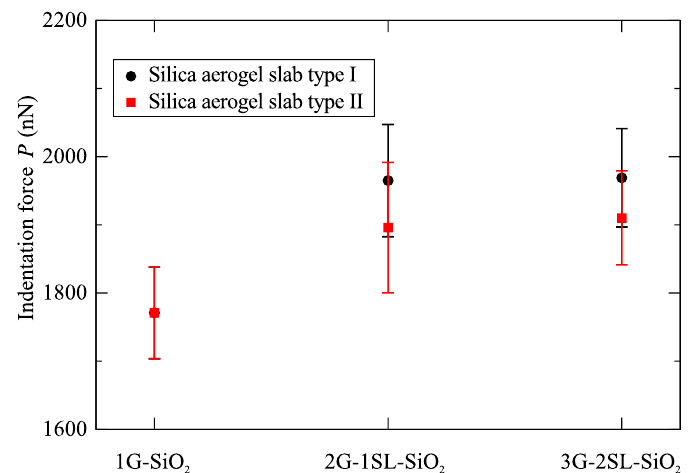
Figure 6. The maximum indentation force of the multi-layered graphene-reinforced silica aerogel systems when indented up to